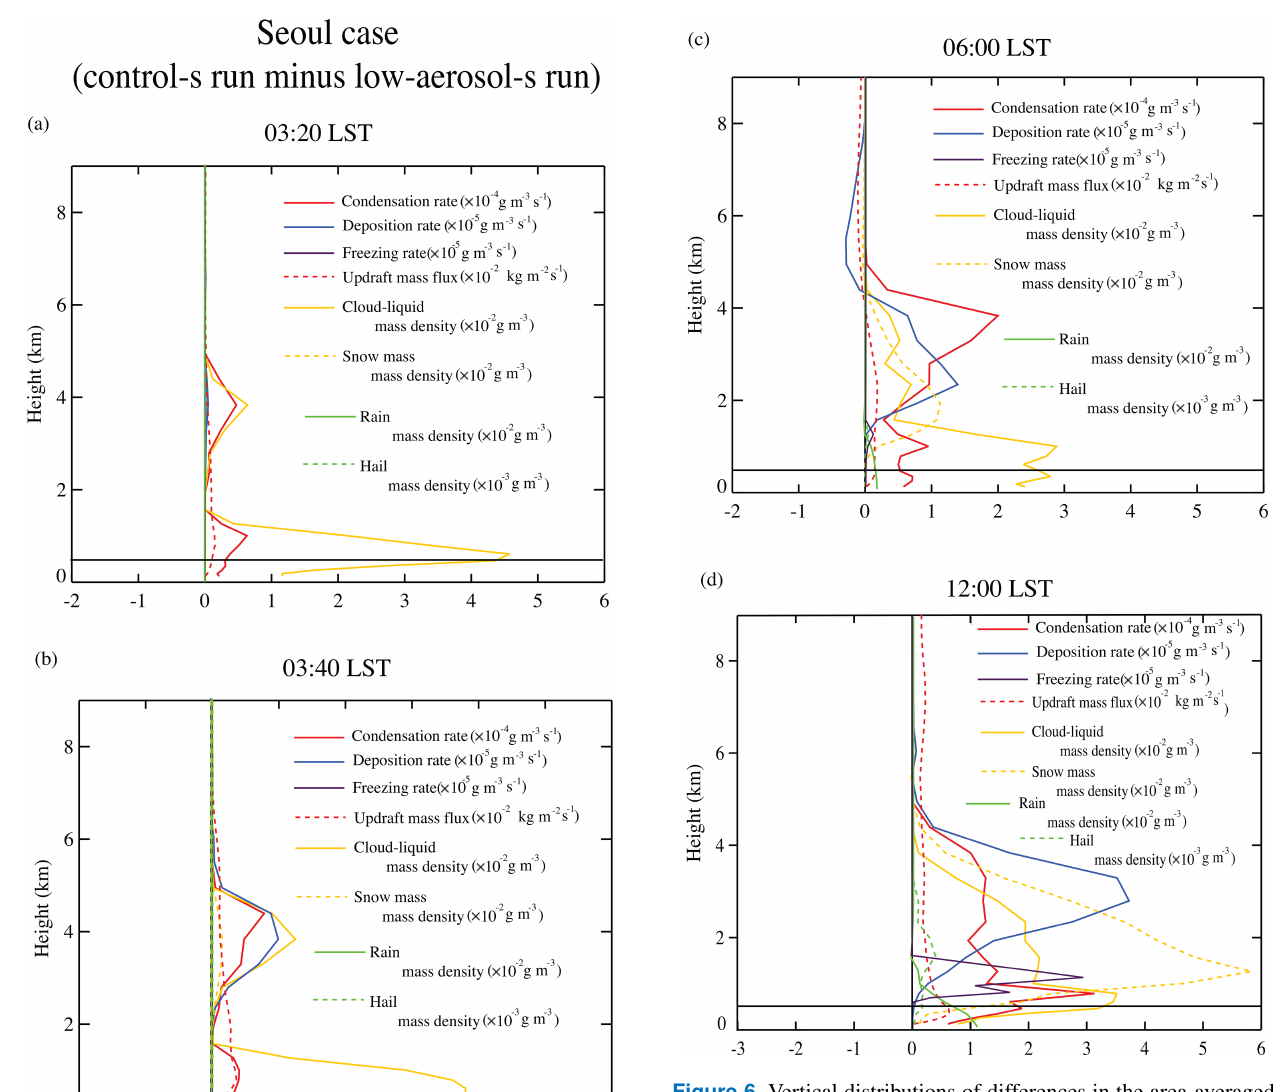
Figure 6. Vertical distributions of differences in the area-averaged condensation, deposition and freezing rates, and cloud-liquid, rain- drop, snow and hail mass density, and updraft mass fluxes be- tween the control-s and low-aerosol-s runs at (a) 03:20LST, (b) 03:40LST, (c) 06:00LST and (d) 12:00LST. The horizontal black line in each panel represents the altitude of freezing or melt- ing. Here, for the sake of the display brevity, snow mass density includes ice-mass density, while hail mass density includes graupel mass